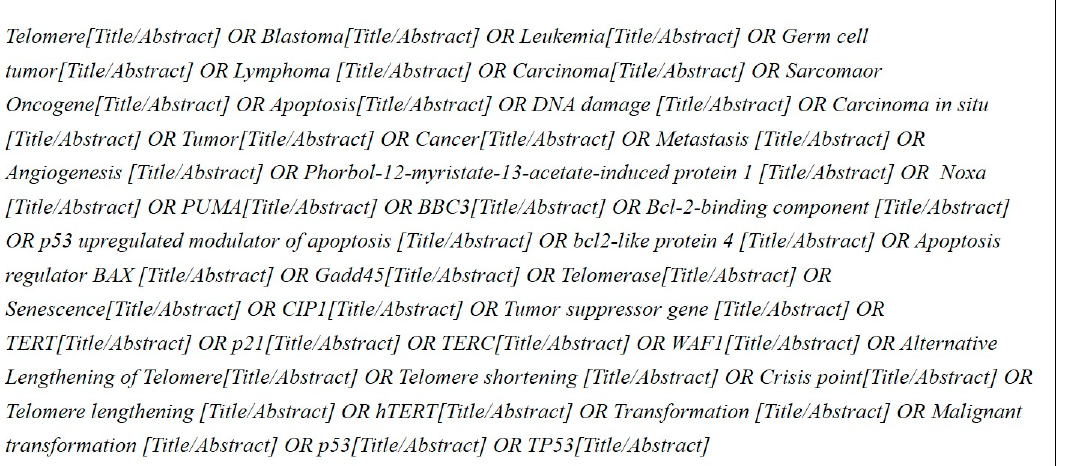
Figure 2. Search query.